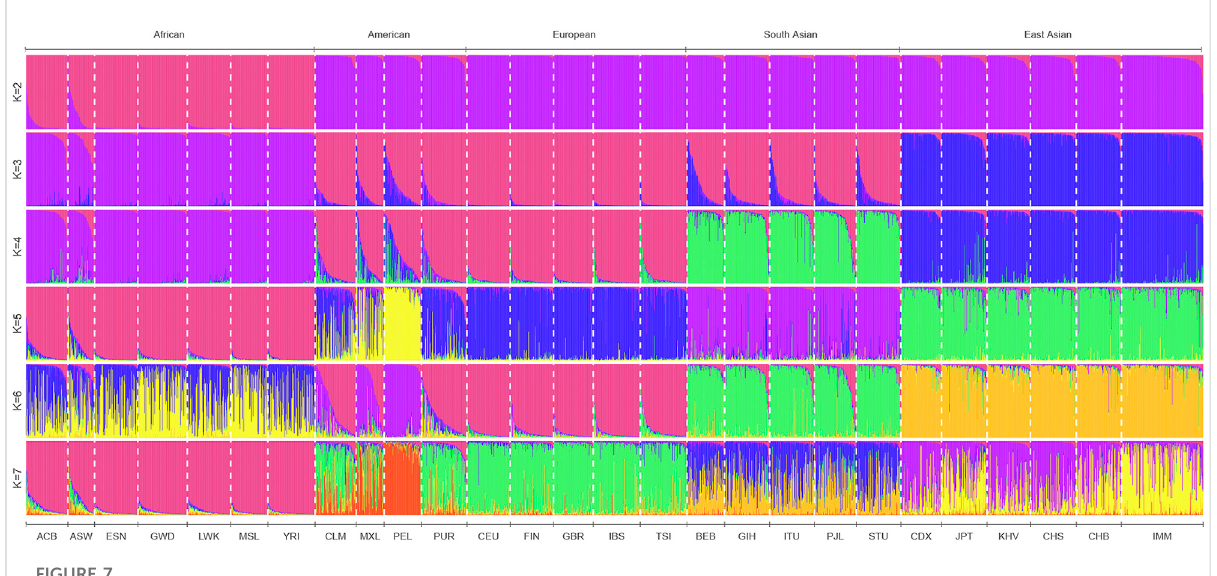
FIGURE 7 STRUCTURE analyses of 27 populations at K = 2-7 based on the 111